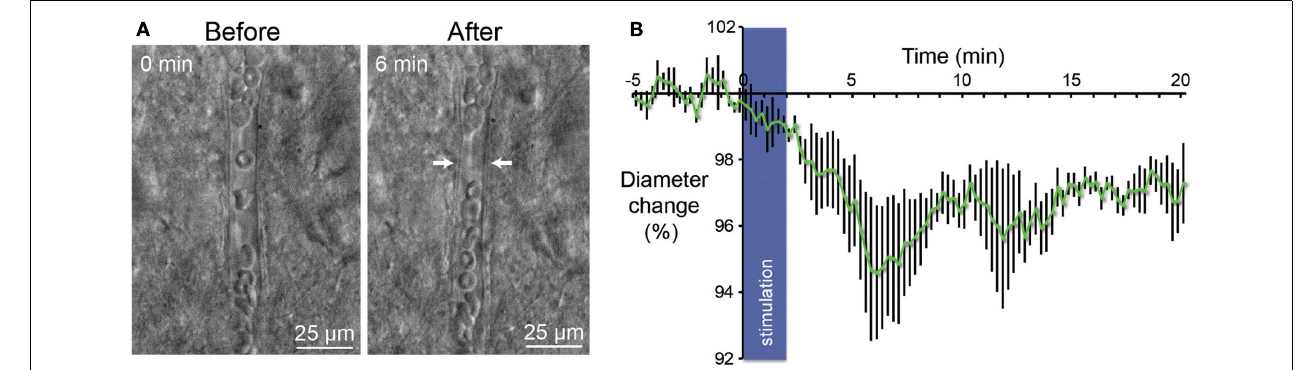
Arrows indicate region of high vascular reactivity. Note the accumulation of red blood cells on both sides of the arrows in the right panel. (B) Mean vascular constriction ± SEM ( n = 5) induced by 2min stimulation at 20Hz (473nm, 5ms pulse width, 35mWmm − 2 ) in the layer II/III of the somatosensory